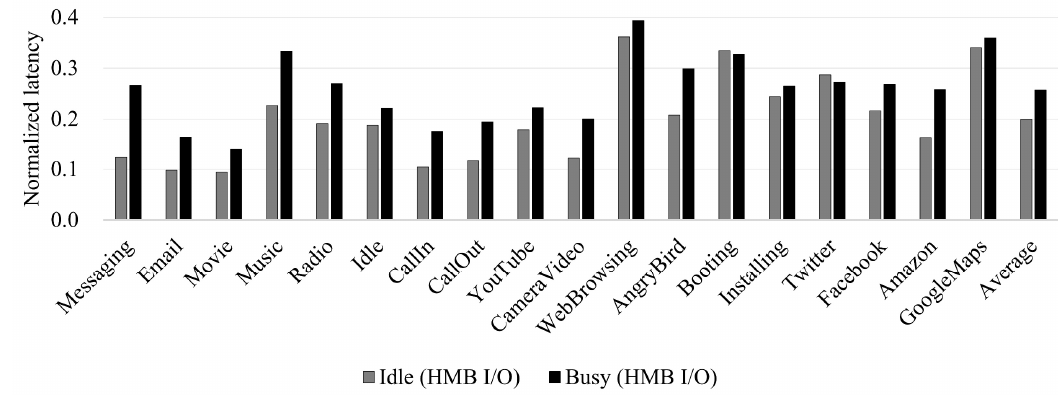
Figure 8. Normalized tail latency of urgent I/O requests in the HMB I/O scheme.